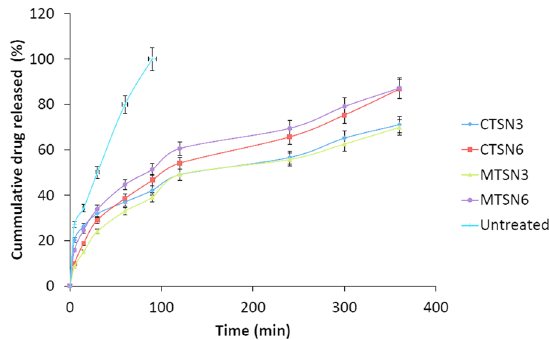
Fig. 9 Release profiles of ciprofloxacin-loaded chemically treated starch nanoparticles, mechanically treated starch nanoparticles, and untreated potato starch. The release study was conducted over a duration of 400 min